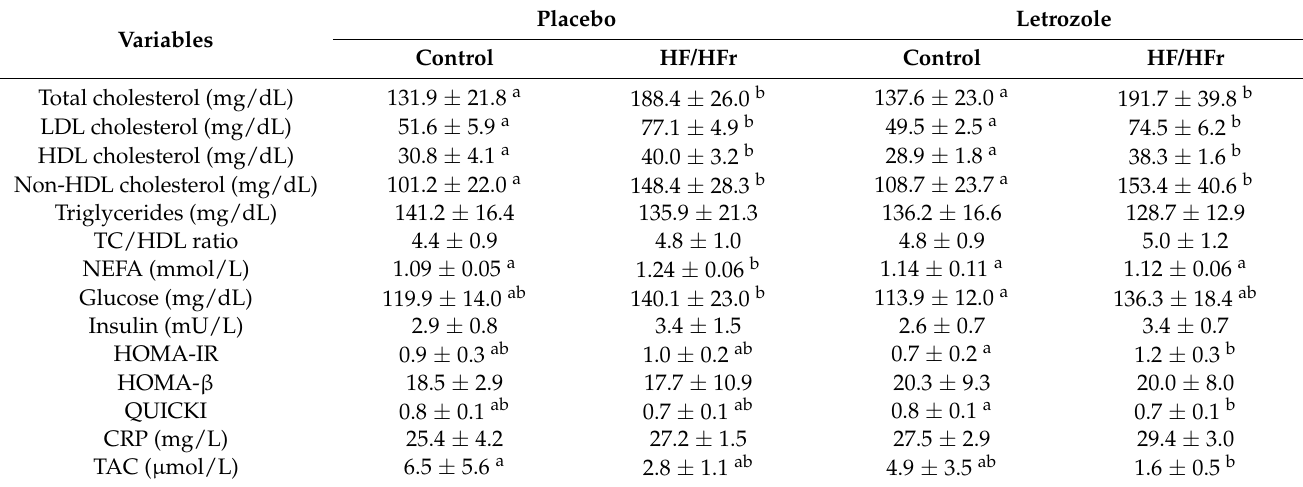
Table 1. Effects of the HF/HFr diet on metabolic parameters in placebo and LET-treated mice.